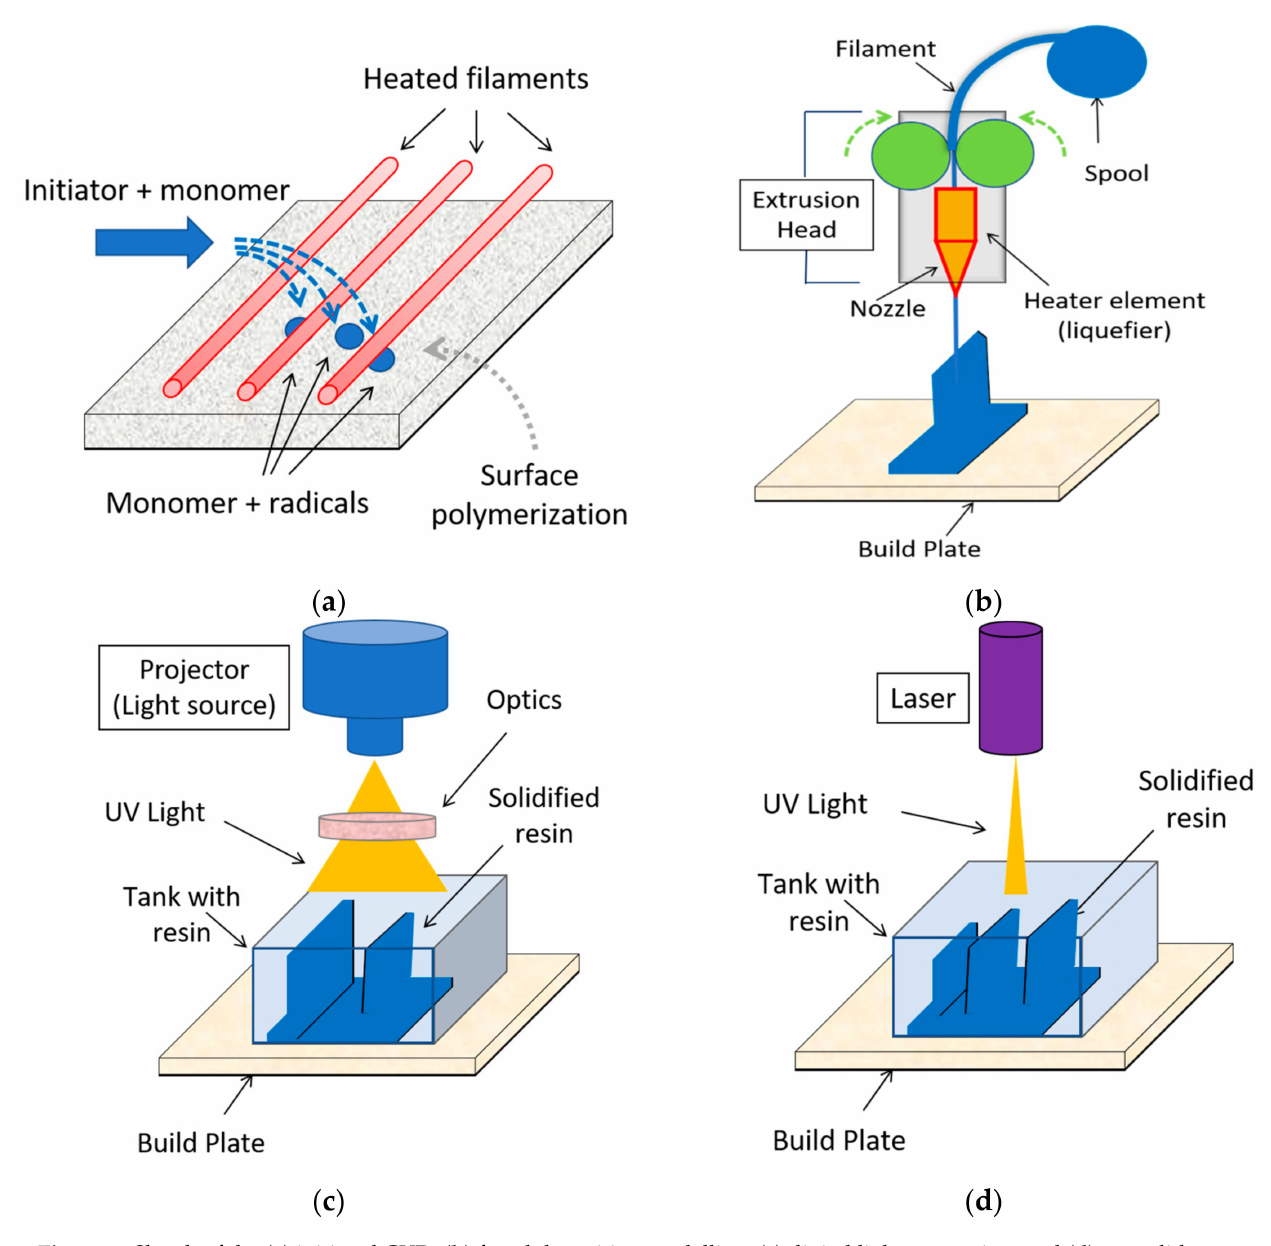
Figure 4. Sketch of the ( a ) initiated CVD, ( b ) fused deposition modelling, ( c ) digital light processing, and ( d ) stereolithogra- phy techniques used to prepare the